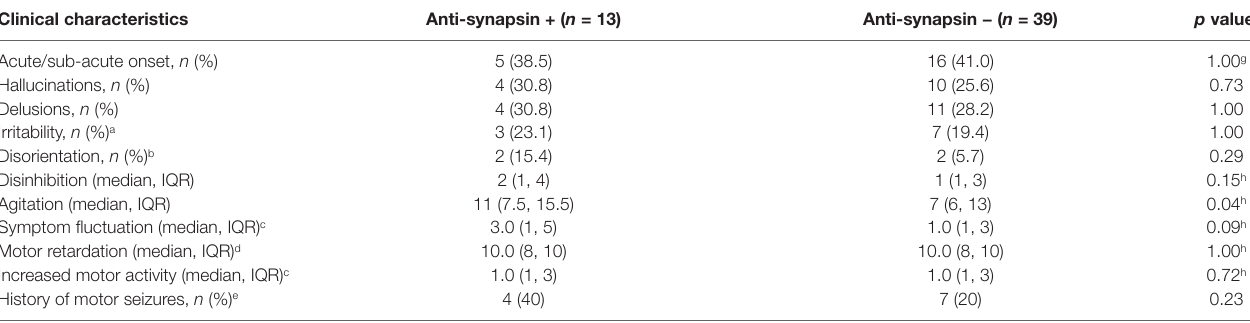
TABLE 2 | Comparison of clinical characteristics in anti-synapsin positive and negative patients. Clinical